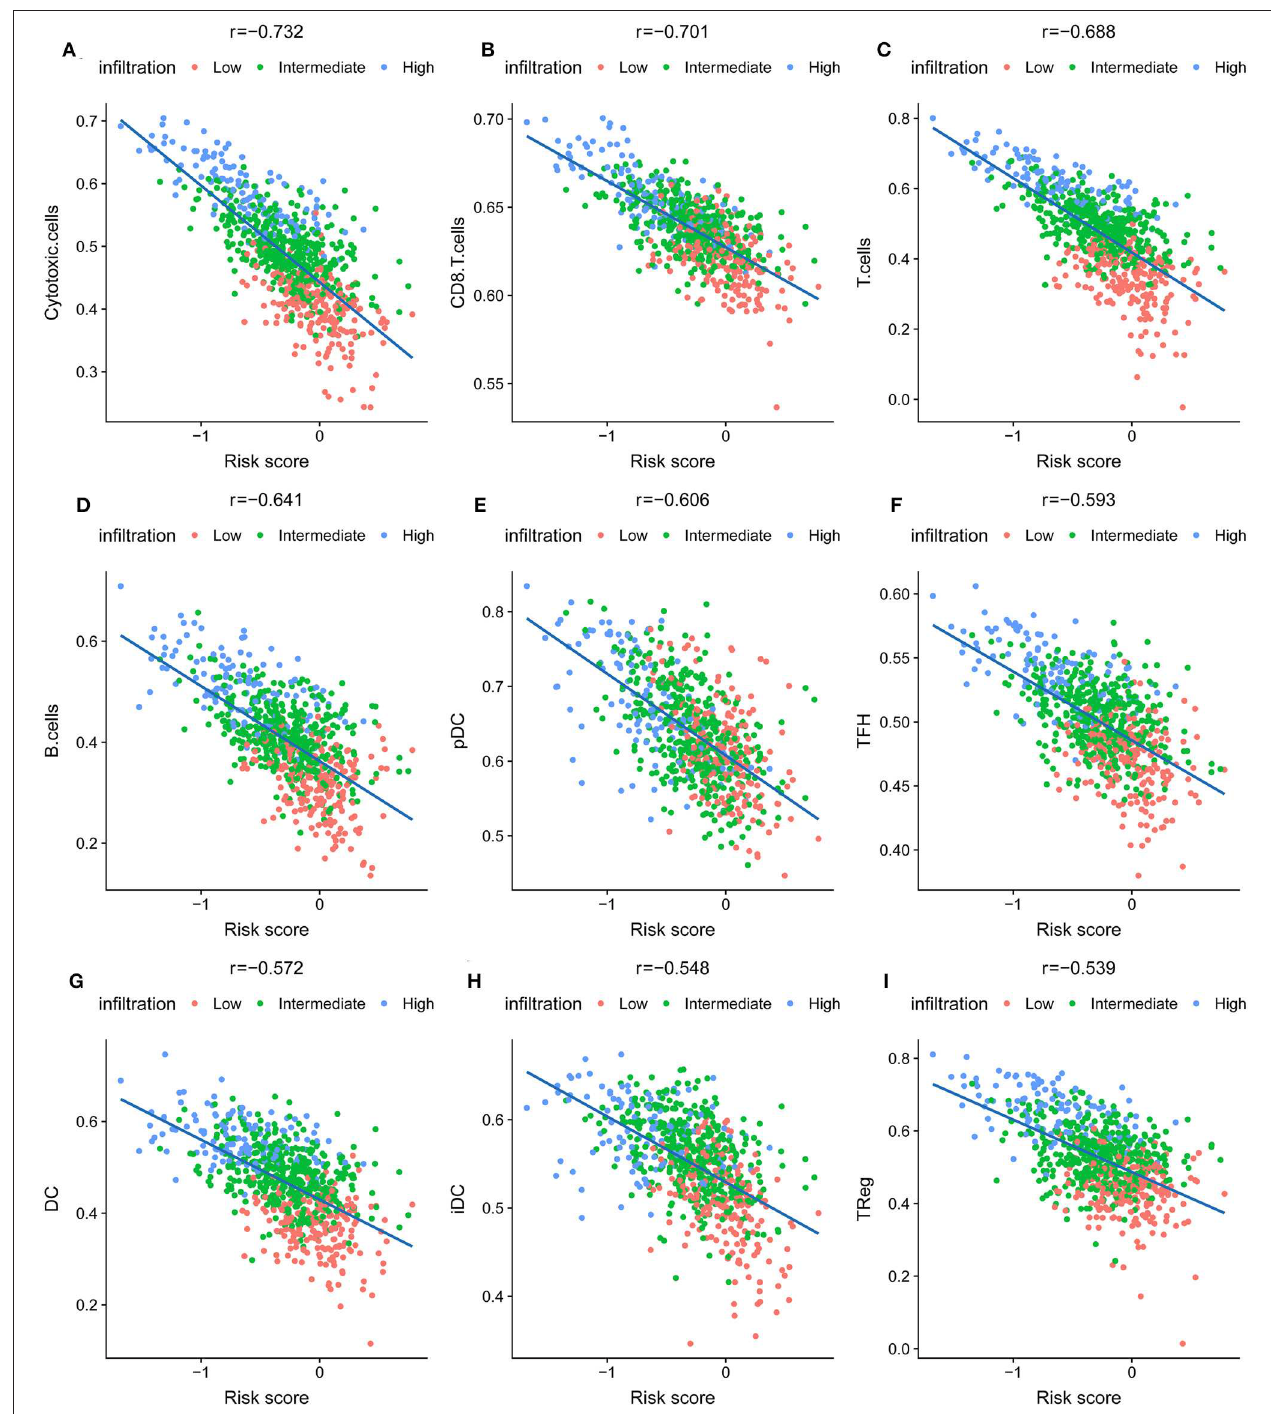
FIGURE 4 | The nine most significant correlations of risk score with immune cell infiltration ssGSEA score. (A) Cytotoxic cells, (B) CD8 + T cells, (C) T cells, (D) B cells, (E) pDC cells, (F) TFH cells, (G) DC cells, (H) iDC cells, (I) Treg cells.